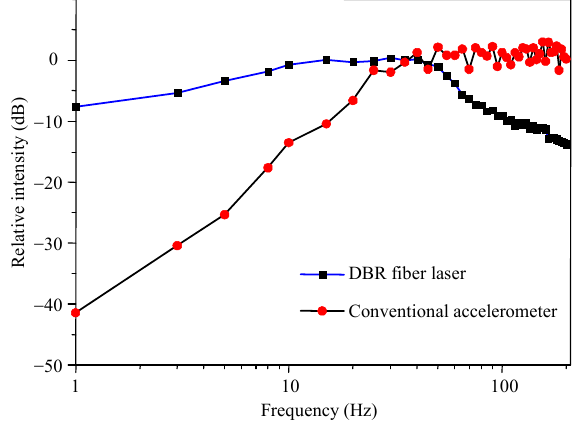
Fig. 3 Measured response at various vibrating frequencies for the DBR fiber laser based measurement and a conventional accelerometer based measurement.